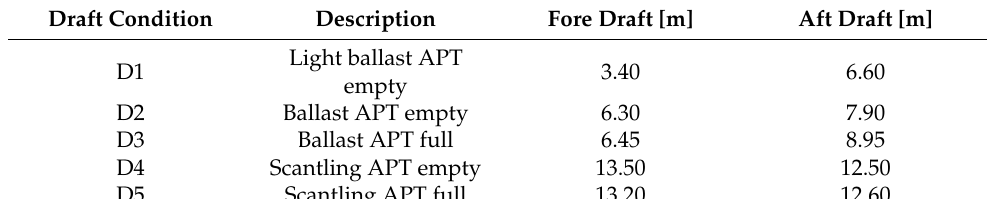
Table 3. Fore and aft drafts under measurement draft conditions.